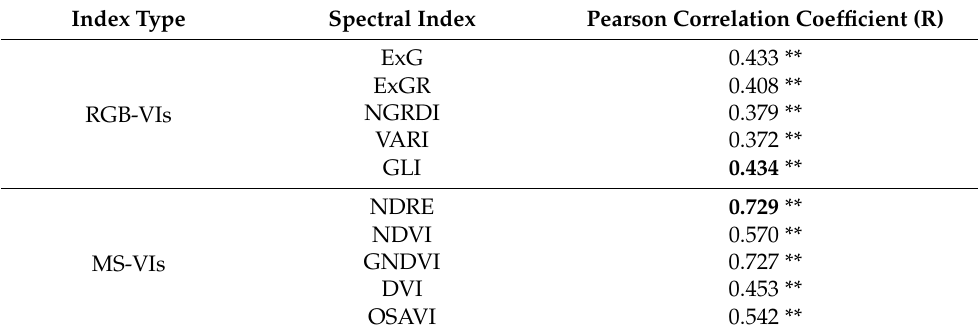
Table 3. Correlation coefficient (R) between image-derived information and LAI.